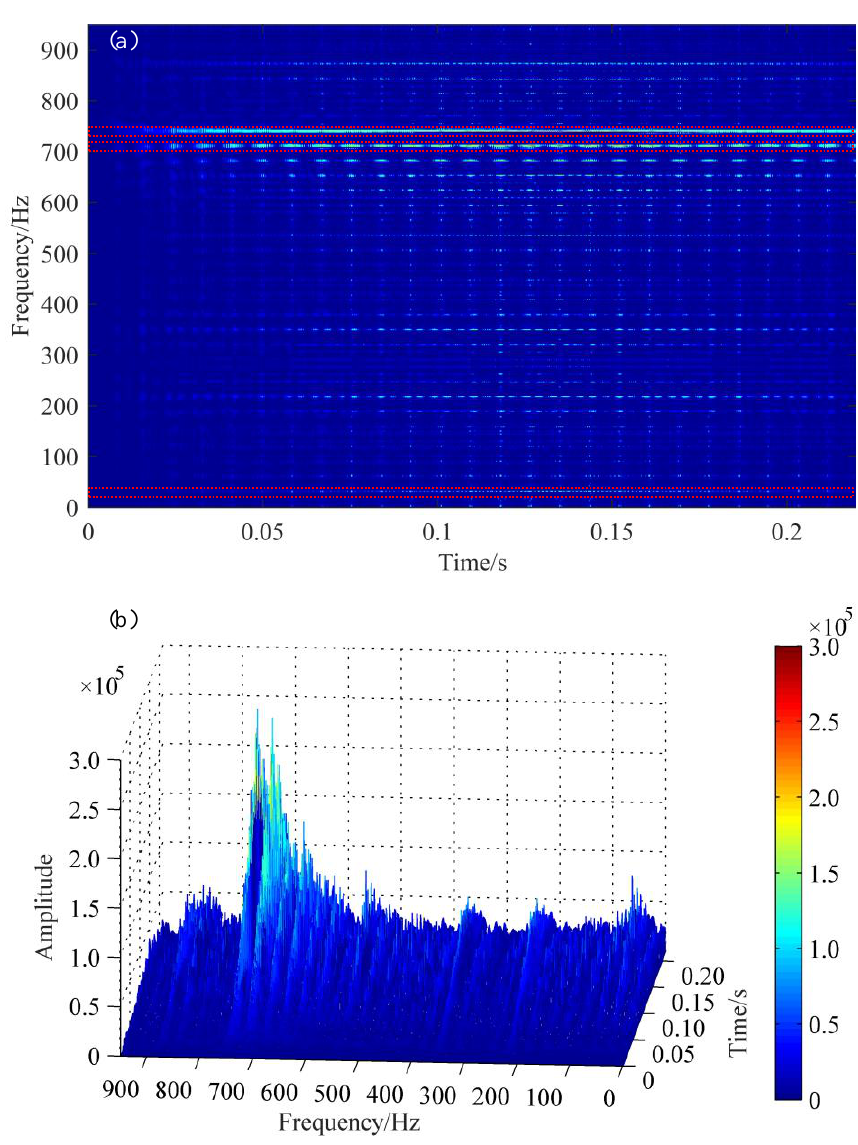
Figure 11. Results of EEMD-WVD analysis of axle-box acceleration caused by real polygonized wheels [27]: ( a ) time-frequency spectrogram; ( b ) time-frequency-energy spectrogram.